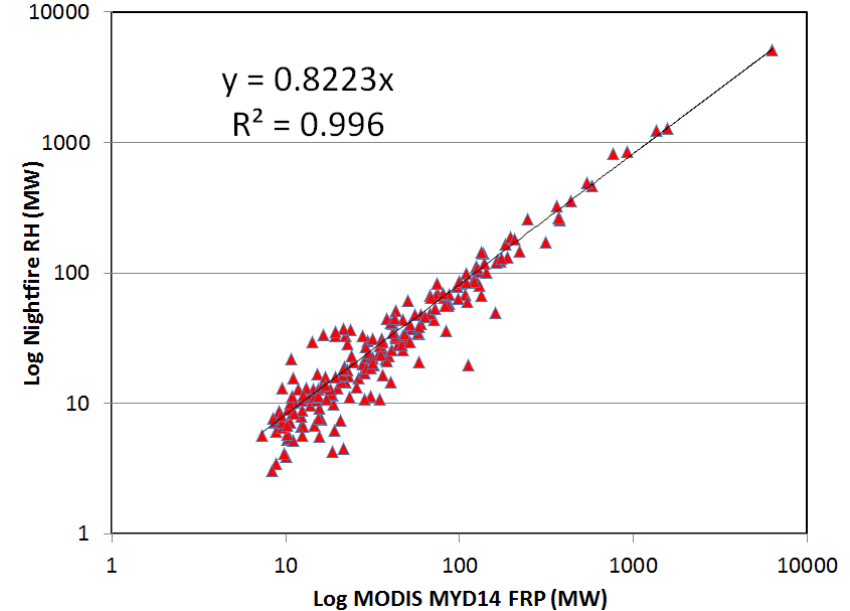
Figure 14. Plot Nightfire Radiant heat (MW) vs. MODIS Fire Radiative Power (MW) from 471 fire clusters observed within six minutes of each other on 19 June